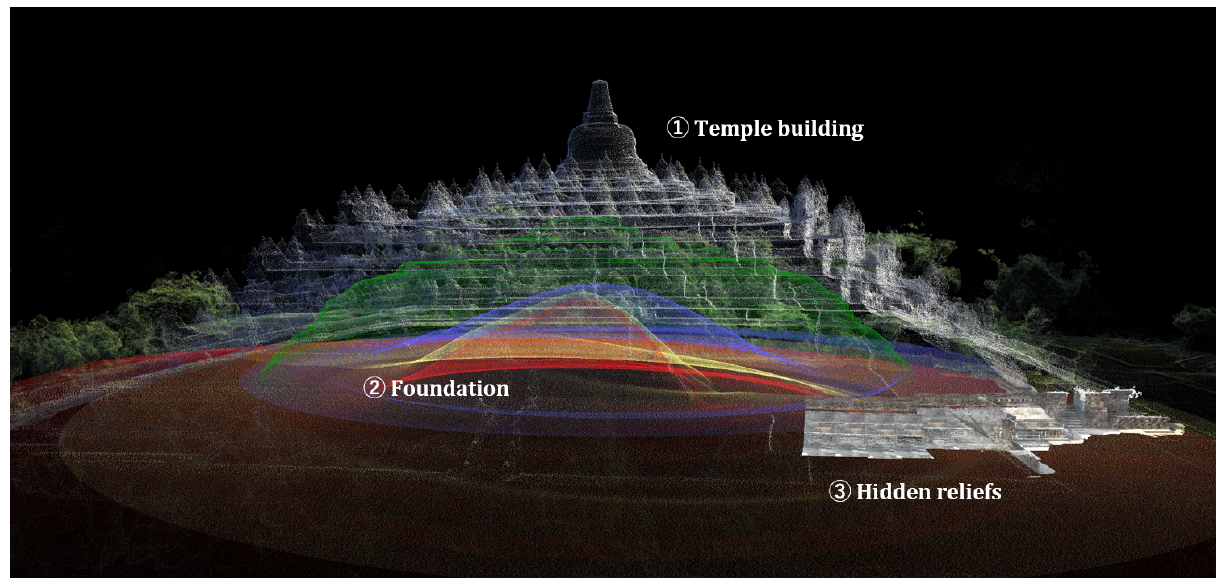
Figure 18. Integrated visualization